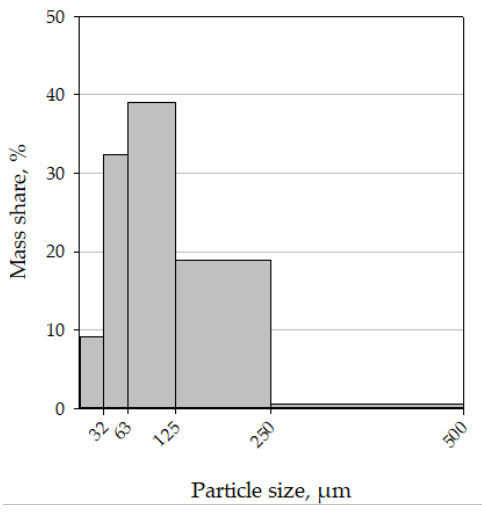
Figure 2. Dust particle-size distribution.